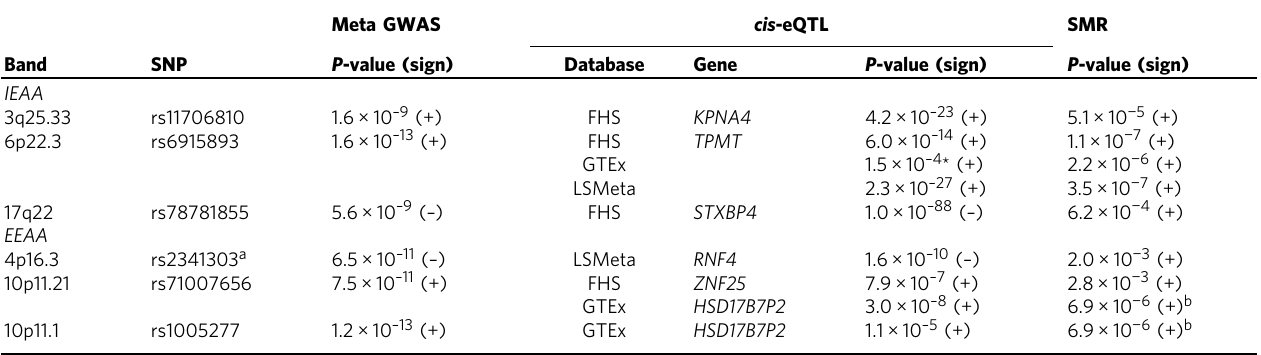
Table 2 Summary of transcriptomic studies for loci associated with epigenetic age acceleration Meta